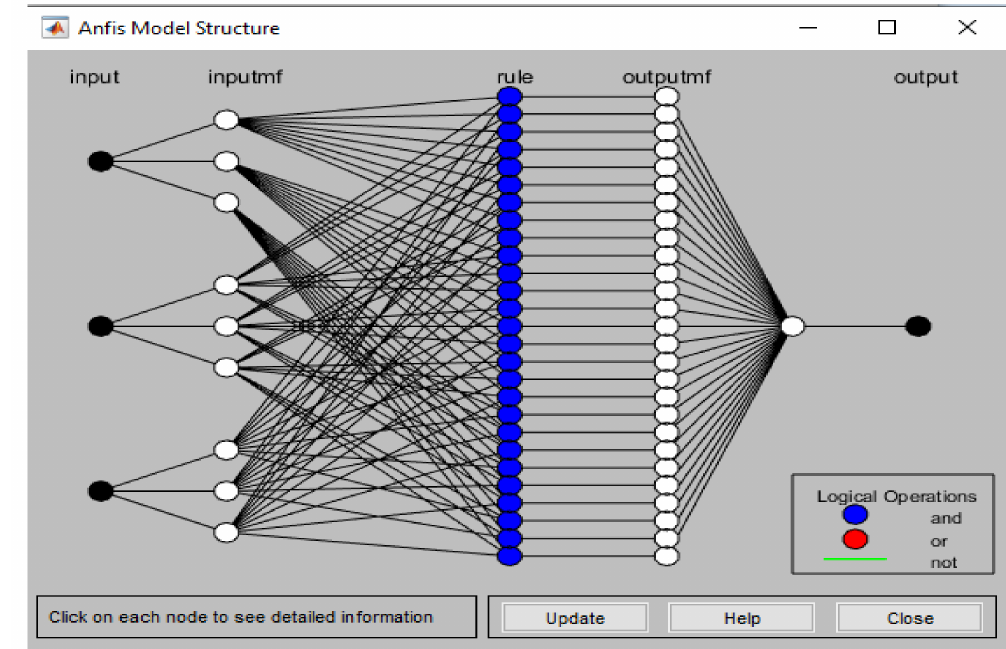
Figure 16. ANFIS model